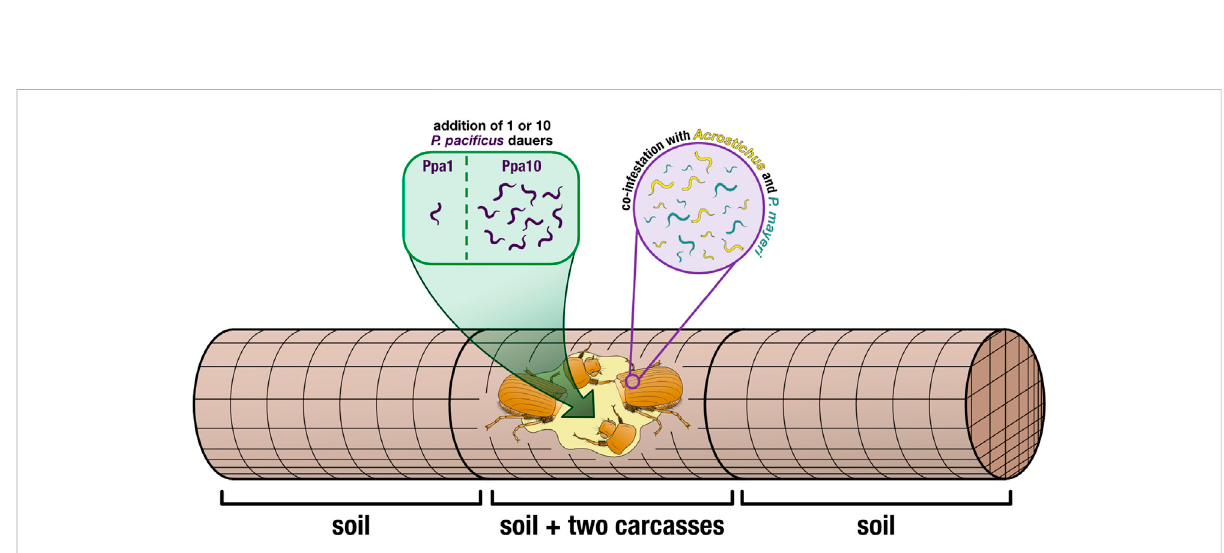
Cage set-up. Two decapitated beetles (to induce nematode emergence) were placed in the center of a wire-mesh cage (allowing for free movement of the worms). Cages either had one P. paci fi cus dauer added (Ppa1) or ten P. paci fi cus dauers added (Ppa10), directly to the carcasses. Wire-mesh dividers compartmentalized the carcasses in the middle, and the empty space was fi lled with soil. The rest of the cage (the two outer compartments) was also fi lled with soil, providing more space for the worms to disperse. Thus, worms were isolated from three locations: the carcasses, the soil in the carcass compartment, and the two soil compartments surrounding the carcass